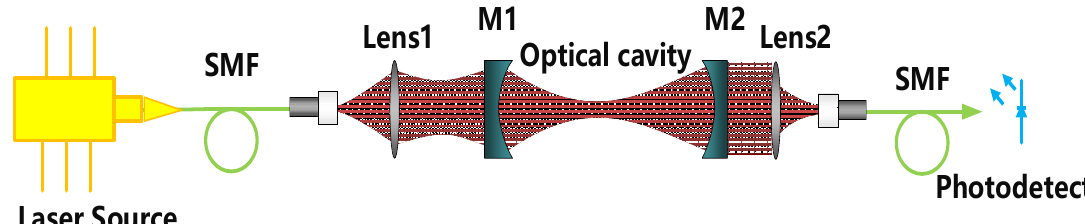
Figure 3. Simulation of CO 2 absorption feature and background interference from of 13 CO 2 , H 2 O vapor and CH 4 .